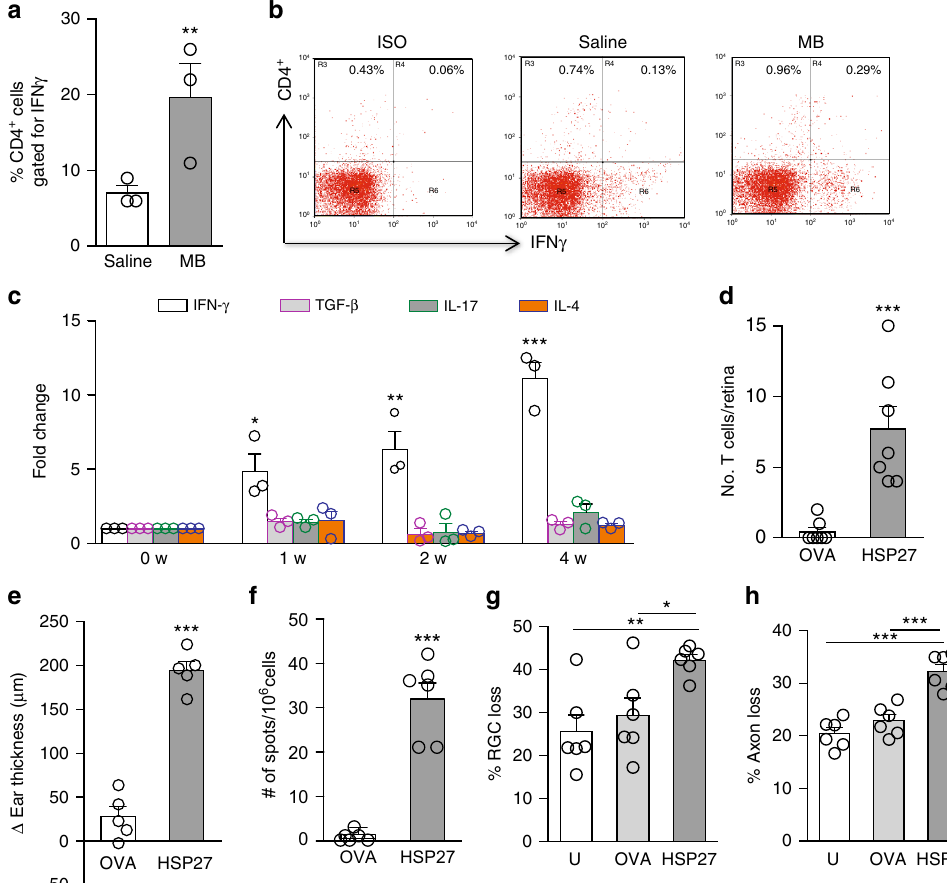
Fig. 4 HSP-speci fi c T cells in fi ltrate the retinas and augment glaucomatous neurodegeneration. a , b In fi ltration of HSP27-speci fi c T cells into the glaucomatous retina. Retinal cells from mice at 2 weeks post saline or MB injection were stimulated by HSP27 in culture, stained for CD4 and IFN- γ , and assayed by fl ow cytometry. Shown are frequencies of INF- γ + -cells in CD4 + gated cells ( a ) and representative isotype control (Iso) and anti-CD4 vs. anti- IFN- γ staining pro fi les ( b ) from the retina of saline- and MB-injected mice. The numbers indicate percentages of cells in the gated regions. Note the increased number of INF- γ + cells among CD4 + cells in MB-injected retina compared to saline-injected retina. ** P < 0.01 ( n = 3/group; each group was pooled from 5 mice). c qPCR quanti fi cation of IFN- γ , TGF- β , IL-17, and IL-4 transcripts in the mouse retinas before (0) and at 1, 2, and 4 weeks post MB or saline injection. ** P < 0.01, *** P < 0.001 by ANOVA ( n = 3/group). d Quanti fi cation of CD4 + T-cell numbers in retinal fl at-mounts of glaucomatous Rag1 − / − mice that received an injection of GFP + /CD4 + T cells from HSP27- or OVA-immunized mice. *** P < 0.001 ( n = 6/group). e , f T-cell responses in ovalbumin (OVA)- or HSP27-immunized mice. B6 mice were immunized with HSP27 or OVA, and 2 weeks later, mice were challenged with HSP27 by intradermal injection in the ear followed by measurement of ear thickness 24 h later ( e ) or mouse splenocytes were isolated, stimulated with HSP27 and then IFN- γ -secreting cells were detected by ELISPOT ( f ). *** P < 0.001 ( n = 6/group). g, h Greater loss of RGCs ( g ) and axons ( h ) in WT recipient mice received adoptive T-cell transfer from HSP27-immunized mice. B6 mice were immunized with HSP27 or ovalbumin (OVA) and 2 weeks later CD4 + T cells were isolated from spleens of immunized mice and unimmunized (U) mice, and adoptively transferred into B6 mice that had been injected with MB 2 weeks earlier. Two weeks after cell transfer, retinal fl at-mounts of recipient mice were stained with Tuj1, and RGCs were counted. ** P < 0.01, *** P < 0.001 by ANOVA ( n = 6/group)